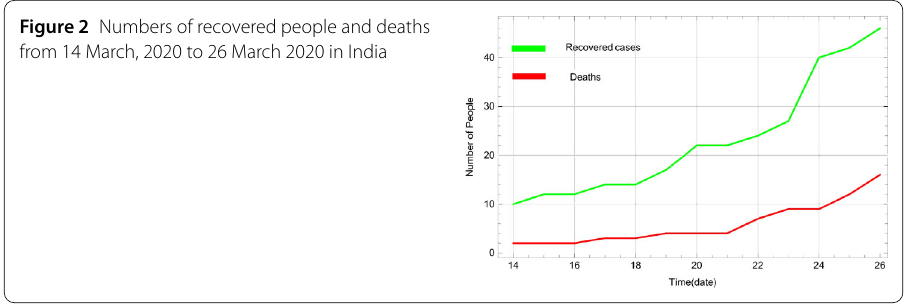
Table 1 Fitted and referred parametric values used in the coronavirus model (1.2) Description of parameter and notation Value Reference Birth rate (cid:2) 53,320.19 Fitted Contact rate α 0.05 [12] Natural mortality rate λ 1 [13] 69.50 × 365 Transmission rate β 0.02844 Fitted Incubation period of I δ 0.0717876 Fitted Incubation period of A μ 0.05 Fitted The proportion of asymptomatic infection φ 0.8243 Fitted Disease transmission coefficient γ 0.121 × 10 –7 Fitted Recovery or removal or rate of I σ 0.09871 [11] Recovery or removal or rate of A ρ 0.854302 κ 0.000398 [11] Contribution of the virus to Q by A ν 0.001 Fitted Removing rate of virus from Q η 0.01